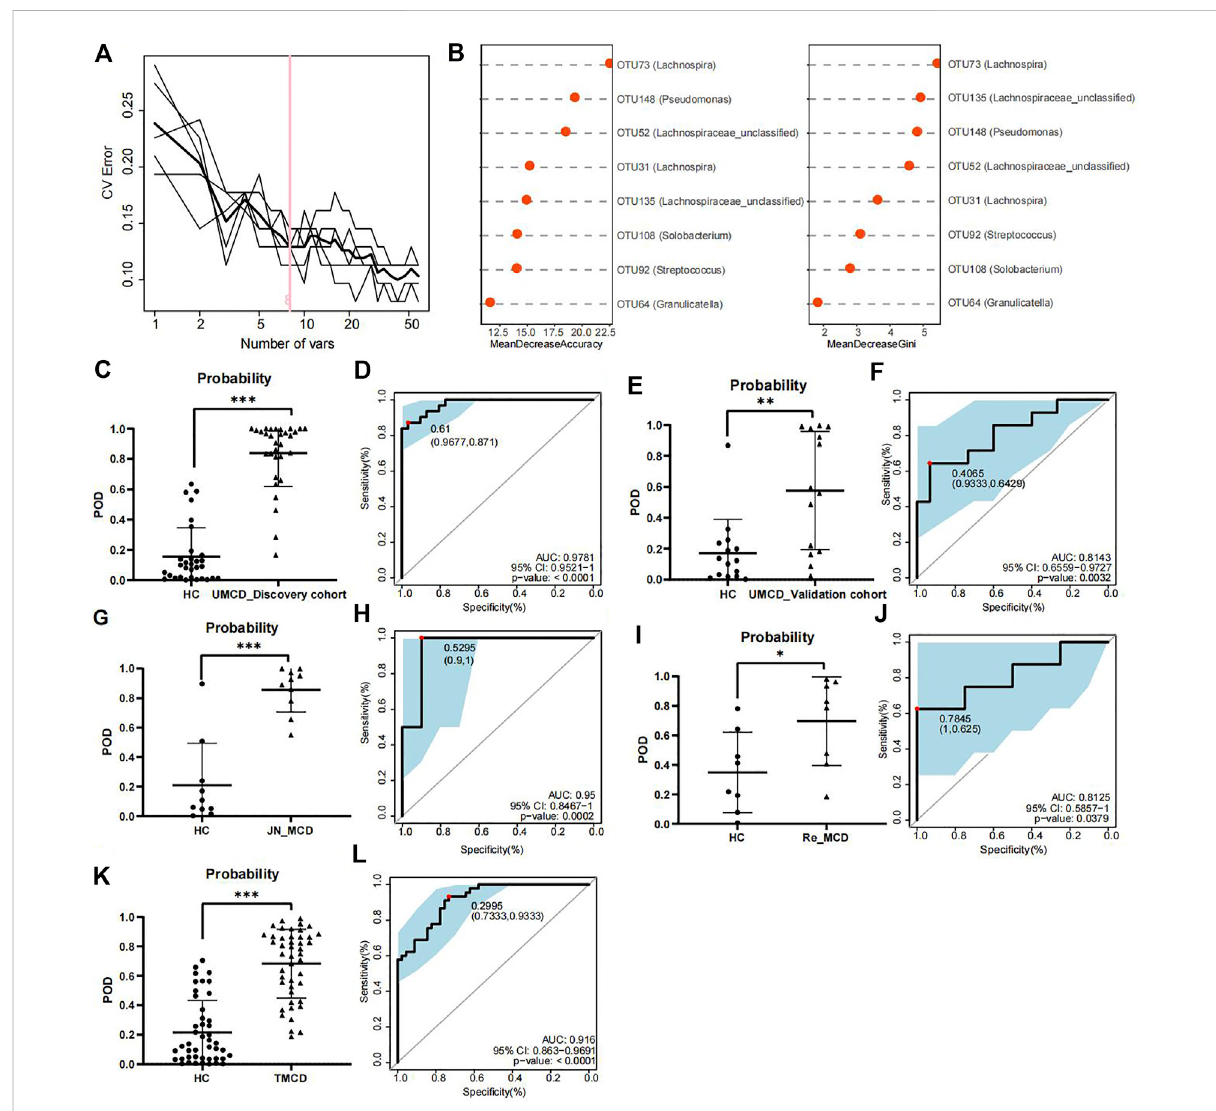
FIGURE 3 Construction and validation of discriminative model. (A) Random forest model showed when containing eight OTUs, the model had lower CV error with fewer variables. (B) Mean decrease accuracy and mean decrease gini showed the contribution values of eight selected OTUs. (C) ProbabilityofdiseasewasobvioushigherinUMCDs( n =30)thanthatinHCs( n =31)indiscoverycohort. (D) Discriminativemodelbasedonobtained microbial biomarkers showed good diagnostic ef fi ciency with an AUC of 0.9781 in discovery cohort. (E) Probability of disease was obvious higher in UMCDs ( n = 15) than that in HCs ( n = 15) in validation cohort. (F) Discriminative model showed good diagnostic ef fi ciency with an AUC of 0.8143 in validation cohort. (G) Probability of disease was obvious higher in JN_MCDs ( n = 10) than that in HCs ( n = 10). (H) Discriminative model showed good diagnostic ef fi ciency with an AUC of 0.95 in JN_MCDs and HCs. (I) Probability of disease was obvious higher in Re_MCDs ( n = 8) than thatinHCs( n =8). (J) Discriminativemodelshowedgooddiagnosticef fi ciencywithanAUCof0.8125inRe_MCDsandHCs. (K) Probabilityofdisease was obvious higher in TMCDs ( n = 45)than that in HCs ( n = 45). (L) Discriminative model showed good diagnostic ef fi ciency with an AUC of 0.916 in TMCDs and HCs. CV, coef fi cient of variation; OTU, operational taxonomic unit POD, possibility of disease; ROC, receiving operational curve;